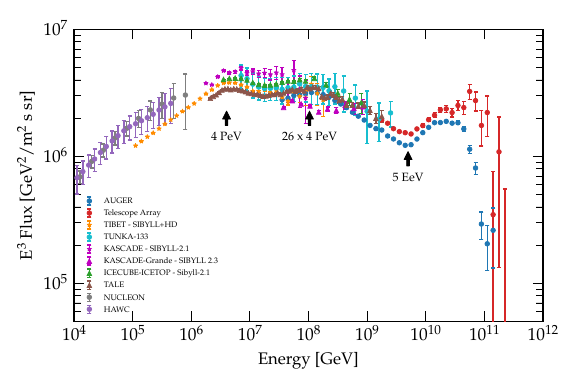
Figure 1. The local interstellar proton spectra. Data compiled by C. Evoli https: // github.com /